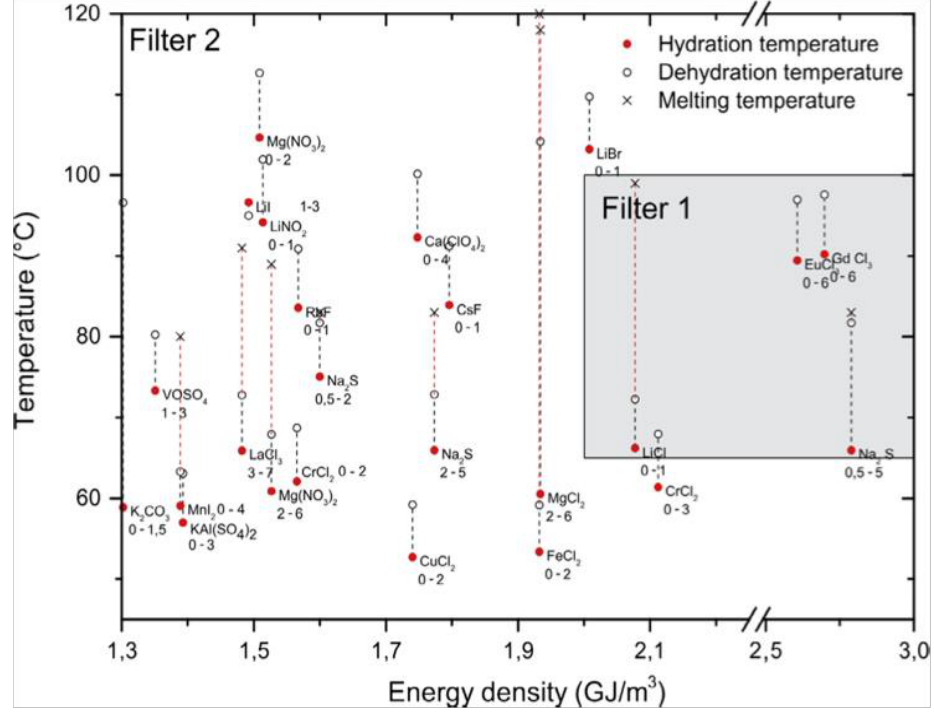
Figure 8. Energy density vs. desorption and sorption temperature at constant condenser and evaporator temperature of 20 mbar and 12 mbar respectively by Donkers et al. [21].